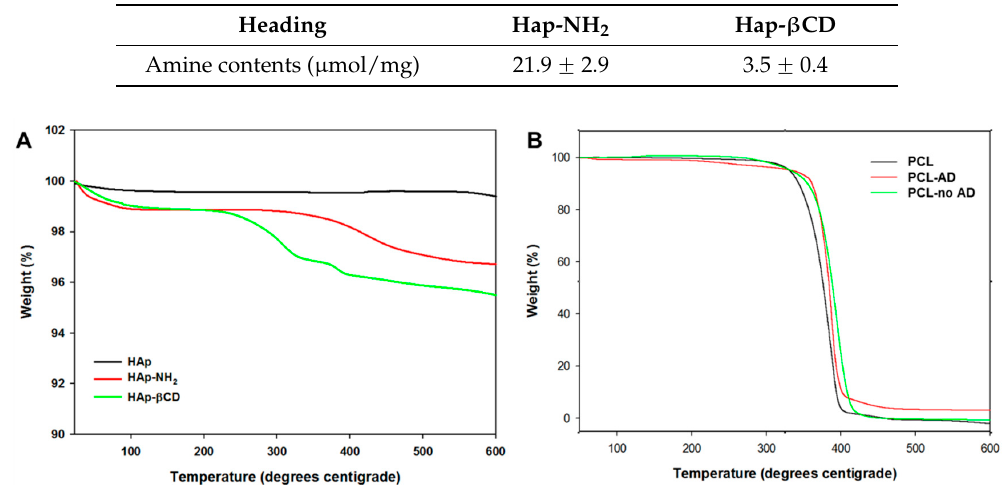
Figure 4. Thermal gravimetric analysis (TGA) of ( A ) surface-modified hydroxyapatite (HAp) composites and ( B ) HAp-coated poly( ɛ -caprolactone) (PCL) scaffolds.